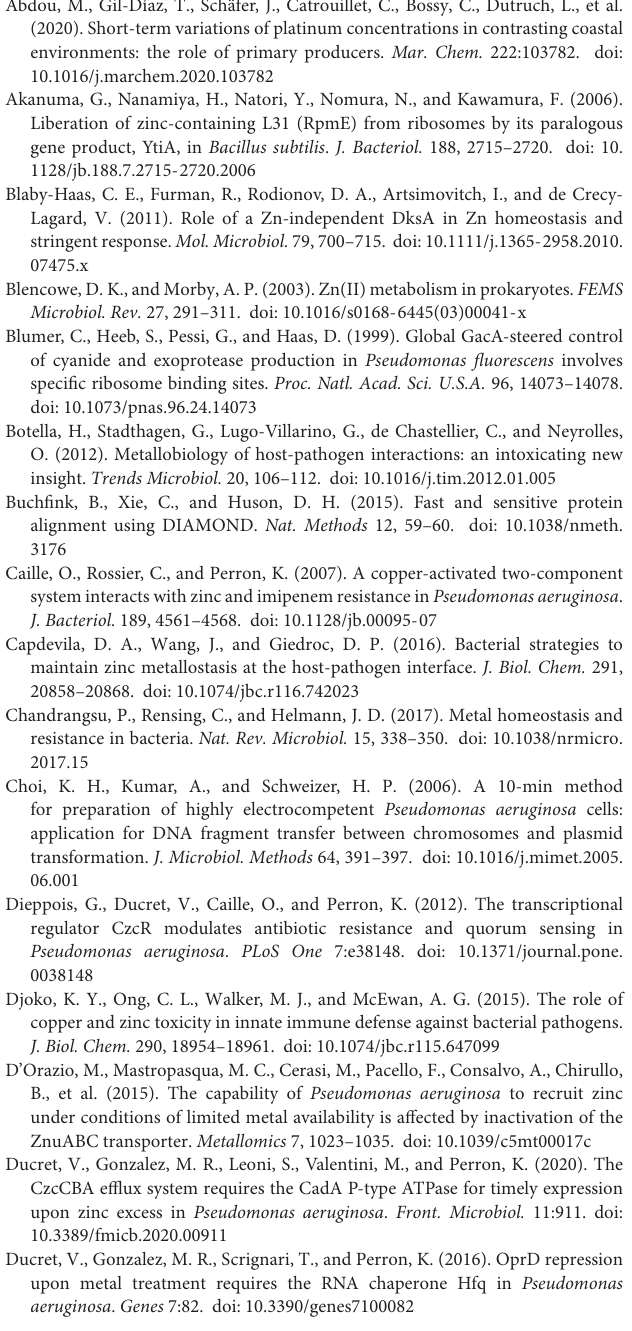
Supplementary Table 3 | mRNA counts of the target genes involved in zinc homeostasis over time, after addition of 2 mM ZnCl 2 . Mean values and standard deviations of three independent experiments are represented. The software assigned an arbitrary value of 1 to undetected mRNAs (gray boxes). Supplementary Table 4 | Strains and plasmids used in this study. Supplementary Table 5 | Primers used in this